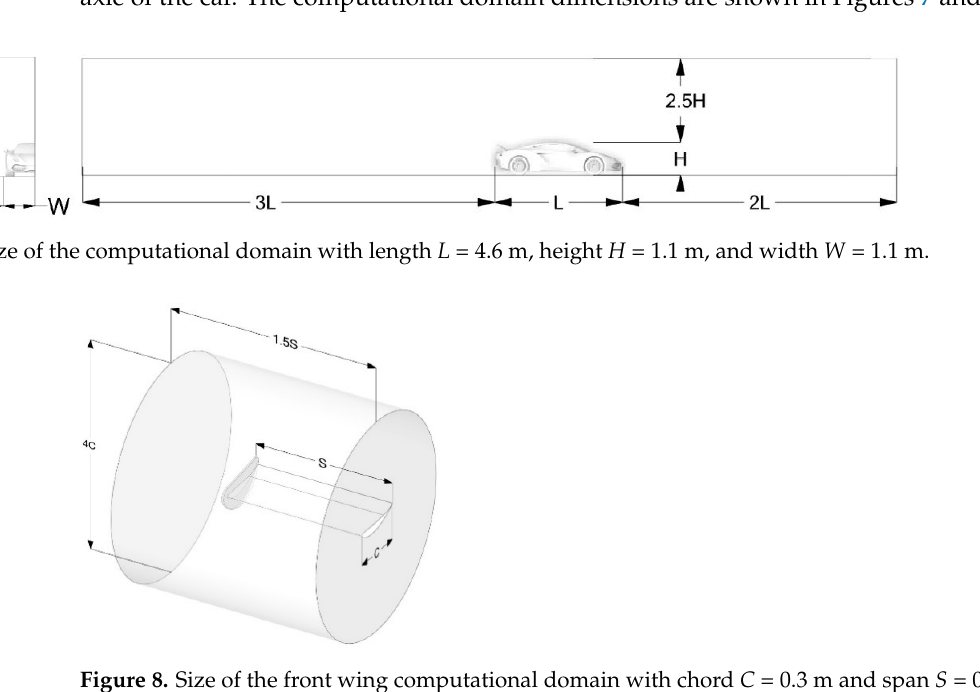
Figure 6. Geometries of the front wing: ( a ) clean front wing; ( b ) front wing with a Gurney flap turned off; ( c ) front wing with a Gurney flap turned on.